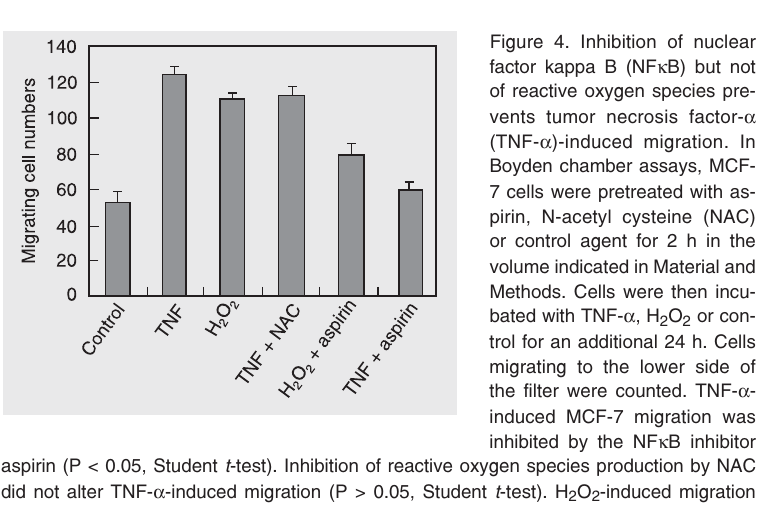
Figure 3. Tumor necrosis factor- α (TNF- α ) decreased the ex- pression of E-cadherin in a nu- clear factor kappa B (NF κ B)-de- pendent way. MCF-7 cells were pretreated with aspirin, N-acetyl cysteine (NAC) or the control agent for 2 h. Cells were then incubated with TNF- α , H 2 O 2 or control. RNA and protein were isolated 24 h later, and the lev- els of E-cadherin and glyceral- dehyde-3-phosphate dehydro- genase (GAPDH) were deter- mined by RT-PCR (A) and West- ern blot (B). Similar results were obtained in three independent experiments.